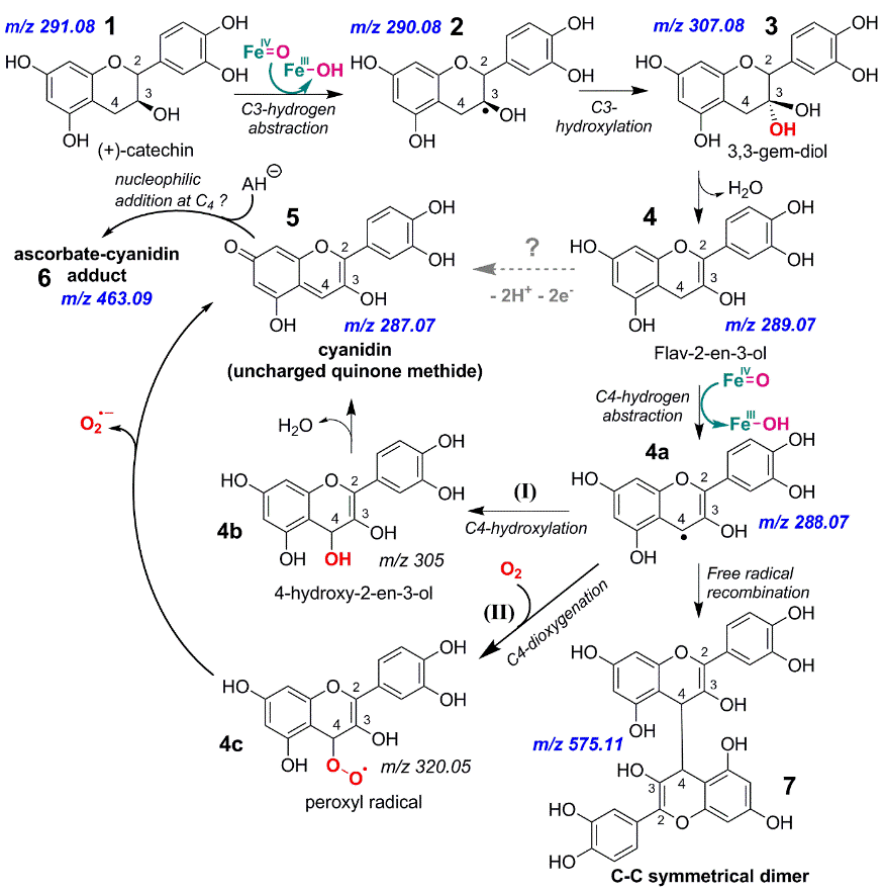
Figure 8. Hypothetical reactional scheme for Vv ANS transformation of (+)-catechin. 2-oxoglu = 2-oxoglutarate; AH 2 = ascorbic acid; All m/z refer to (M+1) cationic species, and m / z which were observed by MS are in bold blue. The expected iron oxidation states of the enzyme active site are indicated only for hydrogen abstraction steps. Note that the flavylium cation of cyanidin would have the same m / z 287.06 as that observed for the mono-protonated form of the uncharged quinone methide since they are tautomers.